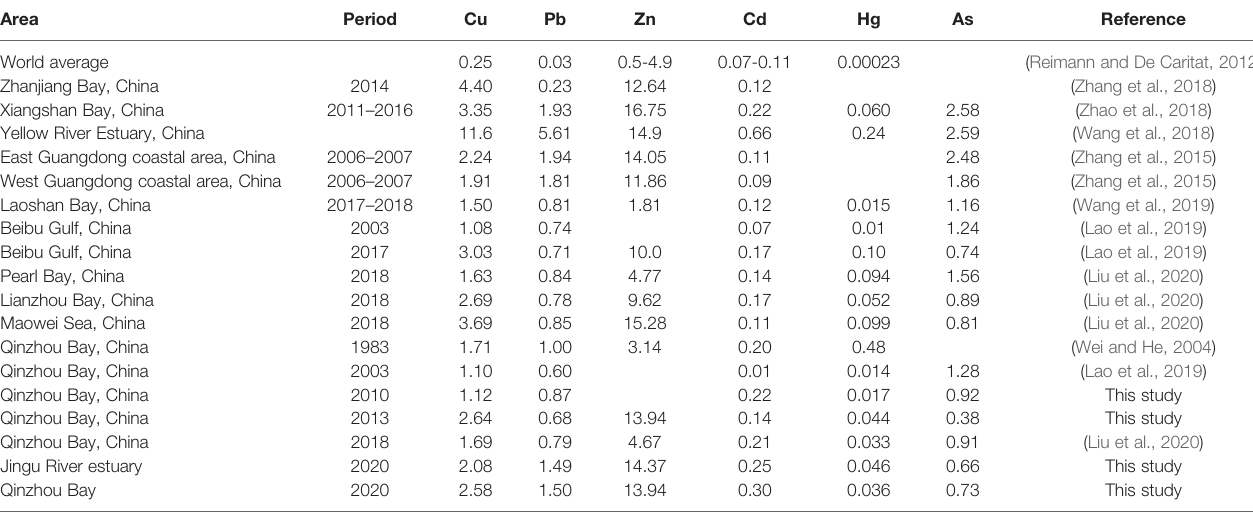
TABLE 3 | Comparison of heavy metal levels in seawater with those in other regions ( m g L -1 ).